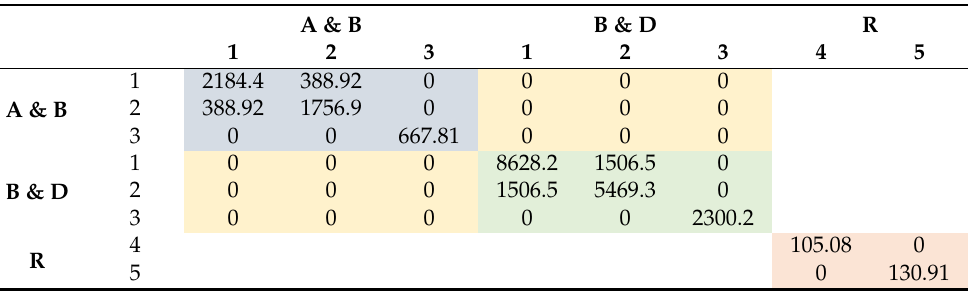
Table 4. Constitutive stiffness matrix A k for the SW model without